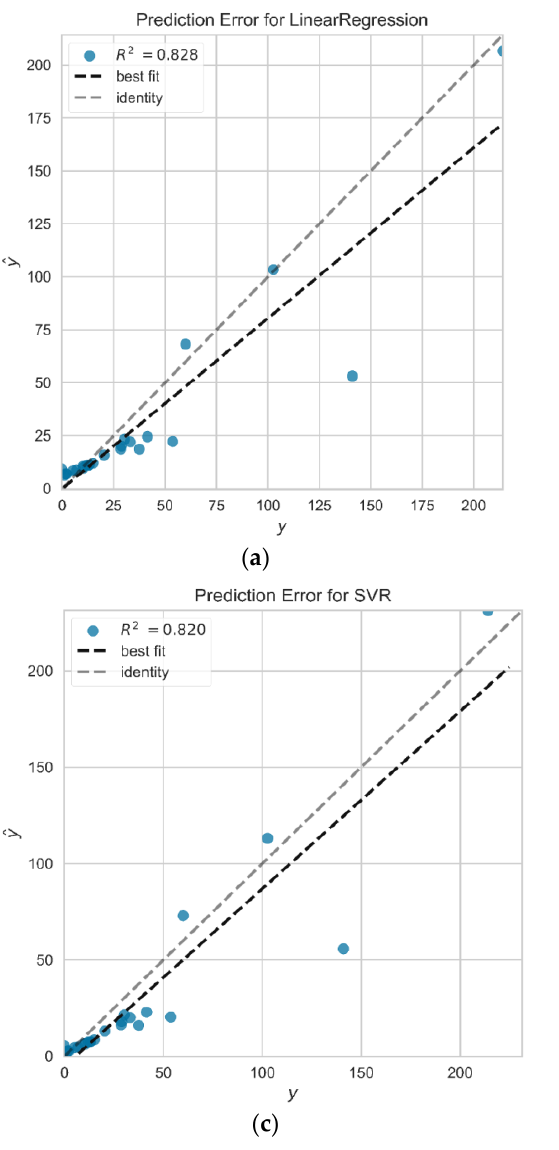
Figure 7. ( a – d ): Prediction errors and lines of best fit of the models.